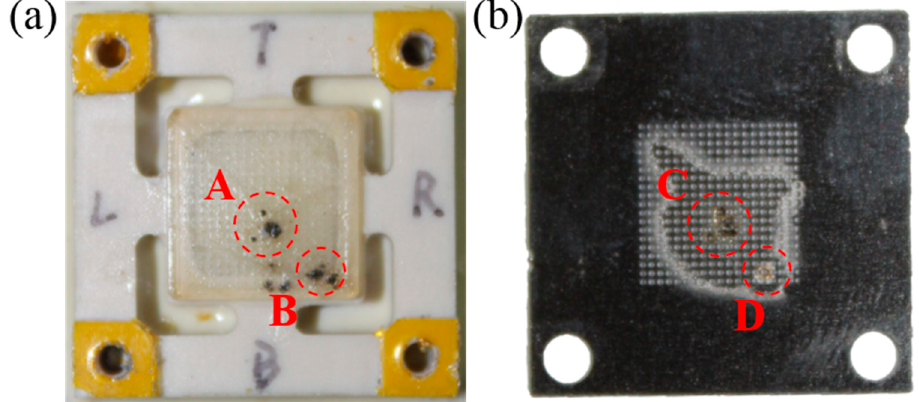
Figure 13. Images of the ILET’s ( a ) emitter array and ( b ) extractor after testing.